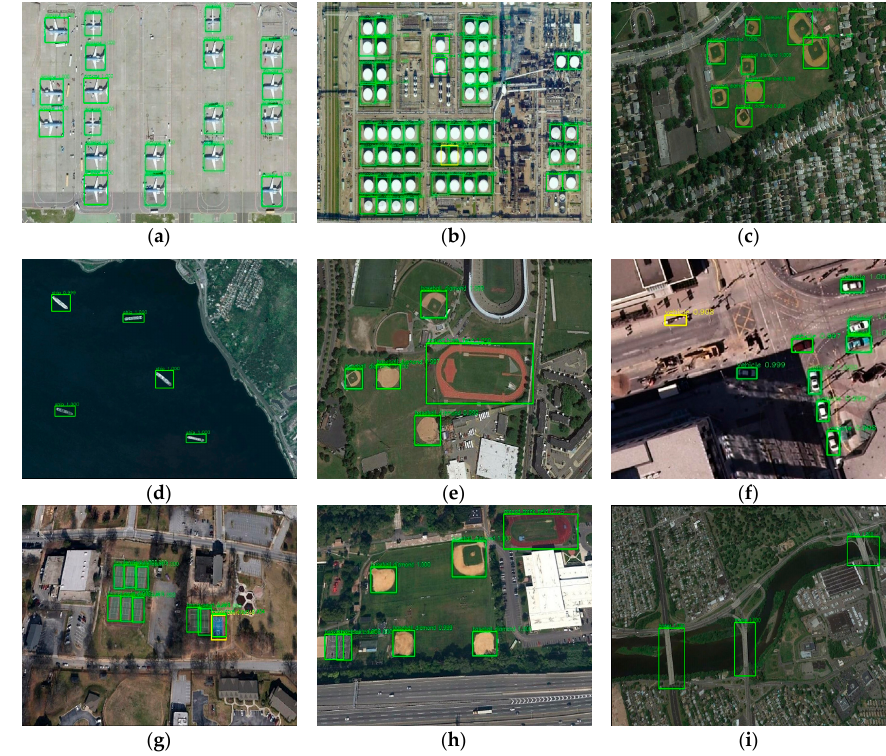
Figure 7. Detection results using our method.